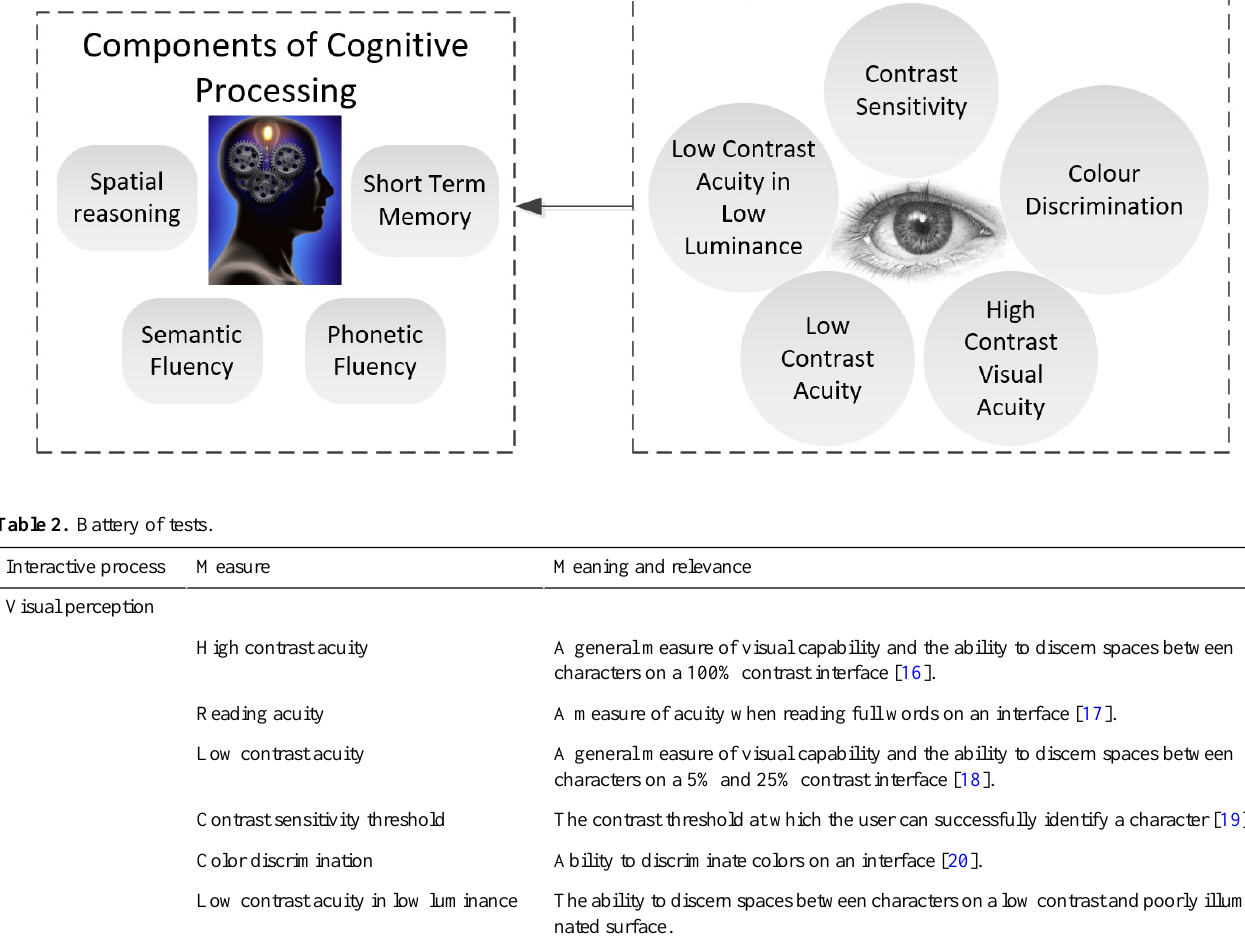
Figure 2. Physiological capabilities required to interact with use case.